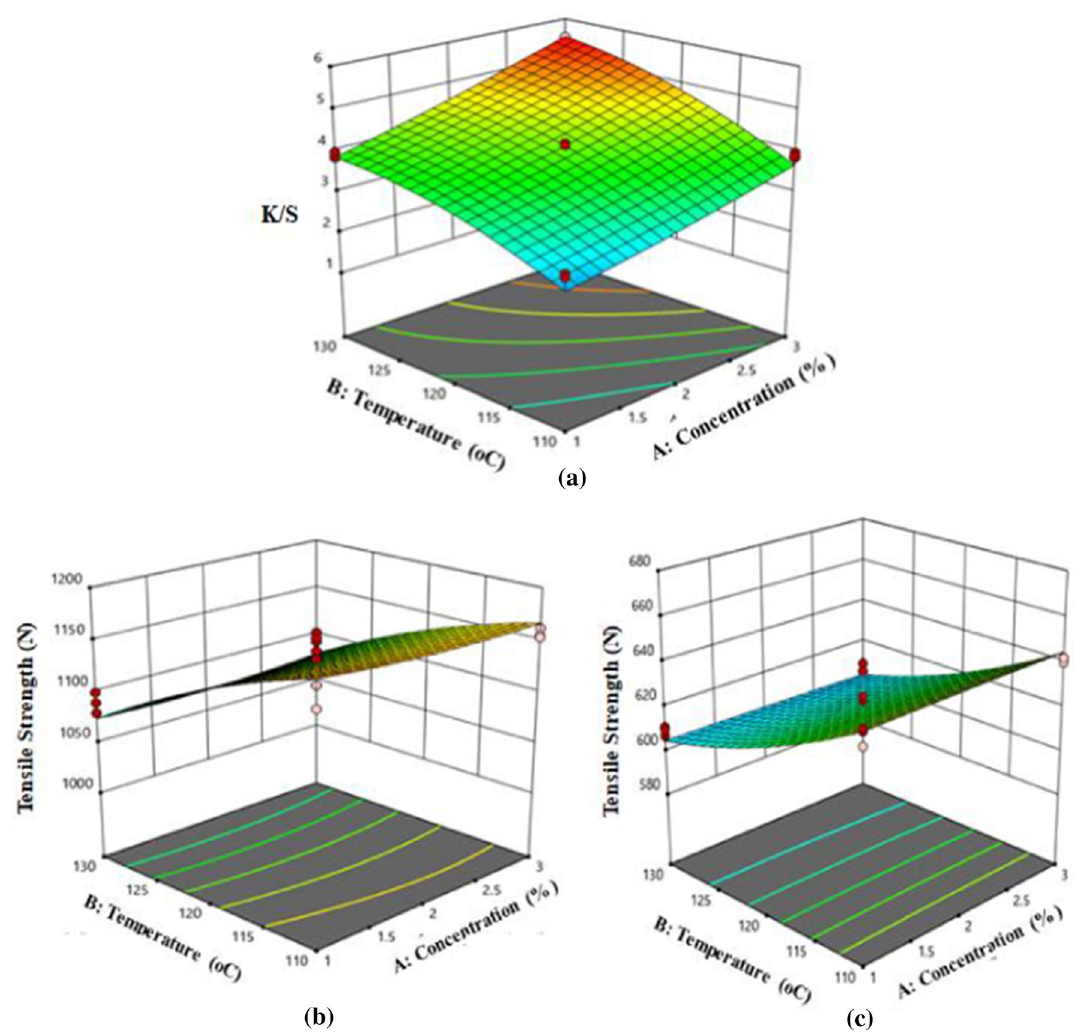
Fig. 10 Optimum values for dye concentration a and tensile strength in warp b and weft c